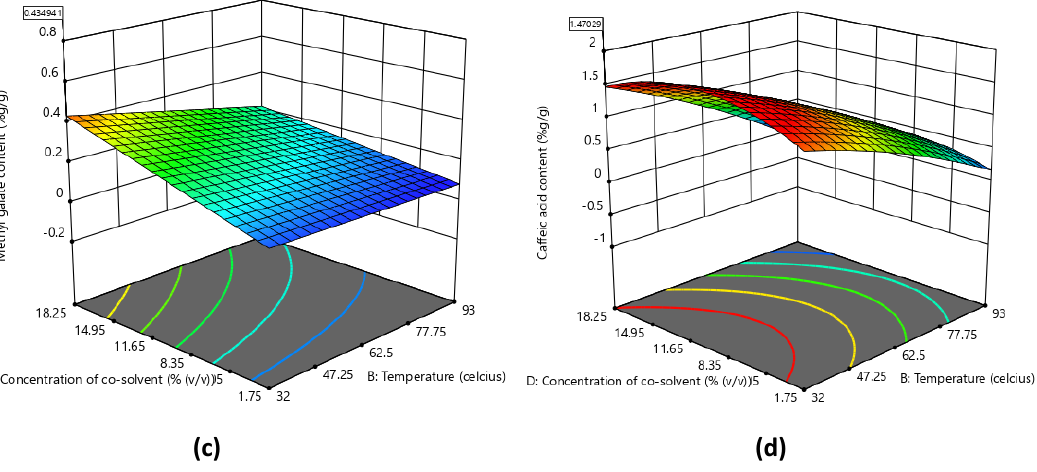
Figure 5. Effect of temperature and concentration of co-solvent on ( a ) extraction yield, ( b ) gallic acid content, ( c ) methyl gallate content, and ( d ) caffeic acid